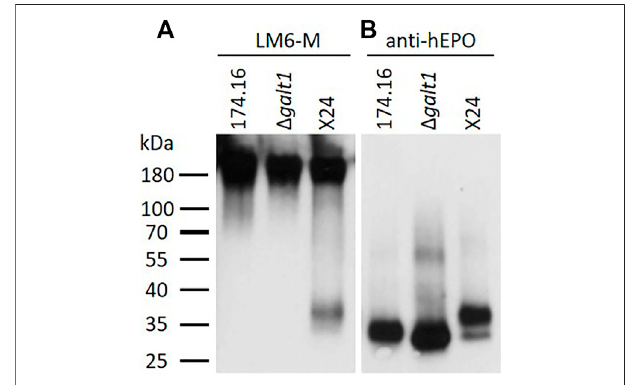
FIGURE 2 | Western blots of precipitated culture supernatants of rhEPO-producing Physcomitrella lines. Five microgram total protein of the precipitated and blotted culture supernatants of the rhEPO-producing lines 174.16, Δ galt1 and X24 were subsequently immunodetected with the anti-1,5- α -L-arabinan antibody (LM6-M, 1:10) (A) and the anti-hEPO monoclonal antibody (1:4,000) (B)